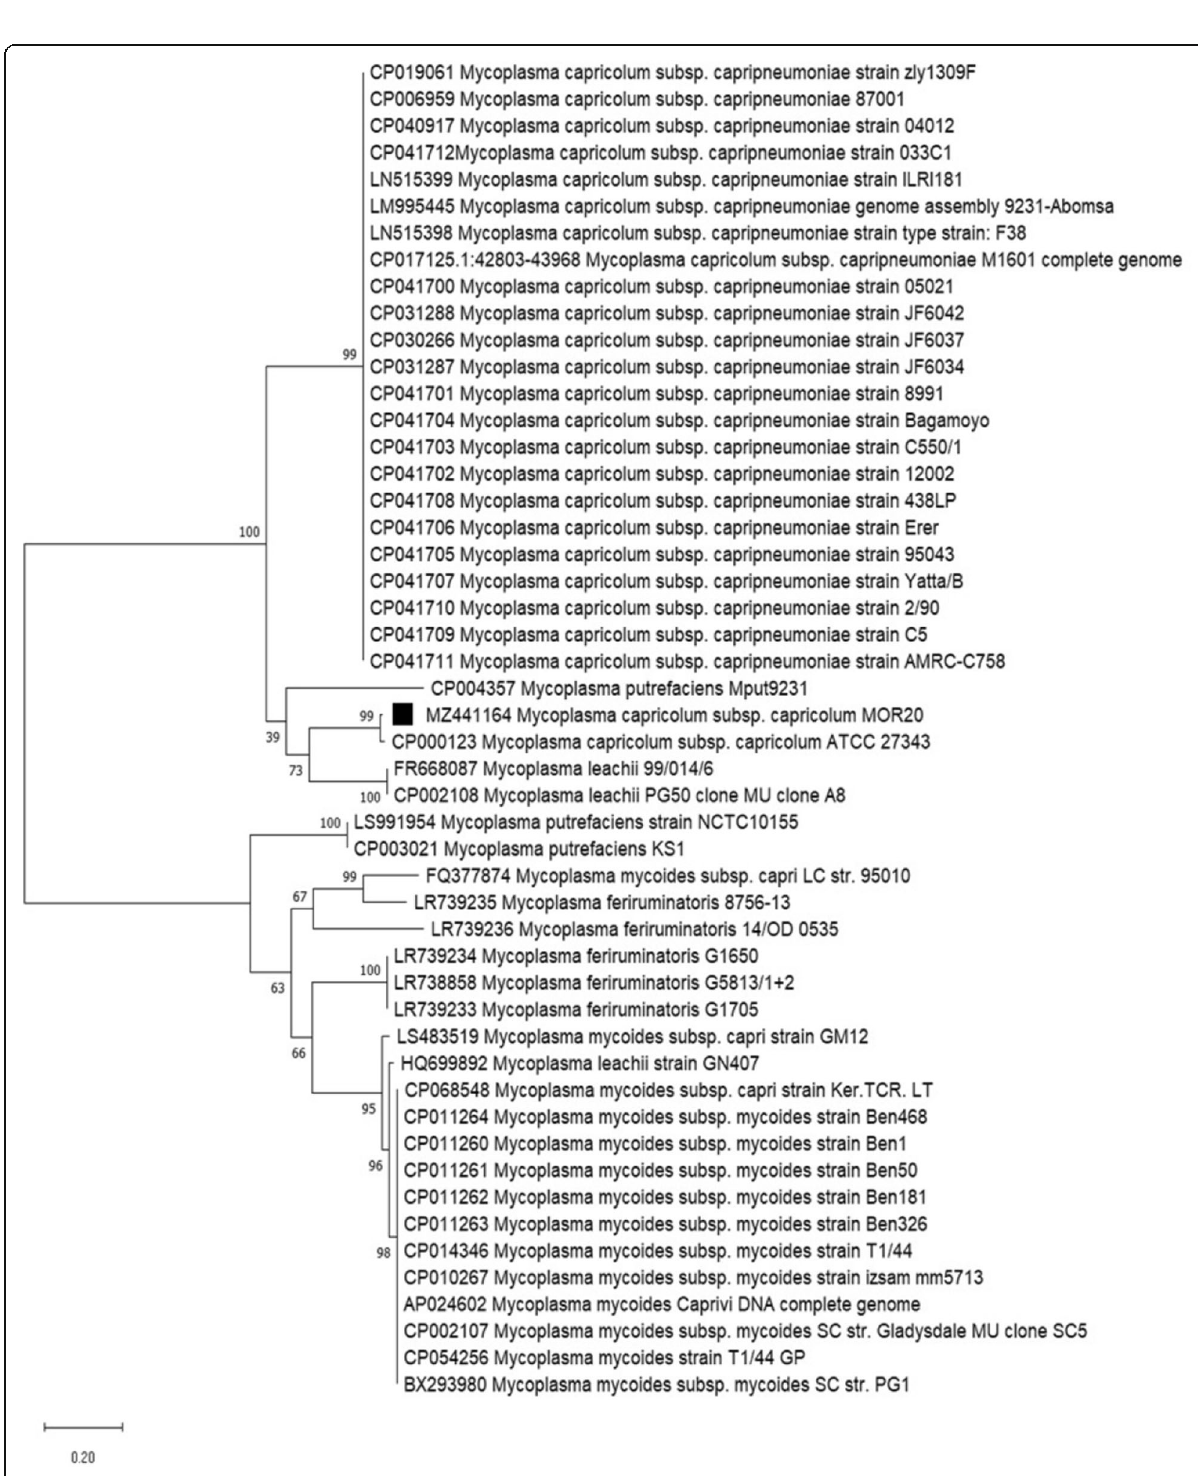
Fig. 2 Phylogenetic and molecular evolutionary analysis of the LppA gene (1356 bp) region conducted using Molecular Evolutionary Genetic Analysis Version 7.0 (MEGA7) with the Kimura two-parameter model and the Maximum Likelihood Statistical Method. The horizontal lines are proportional to the distance among